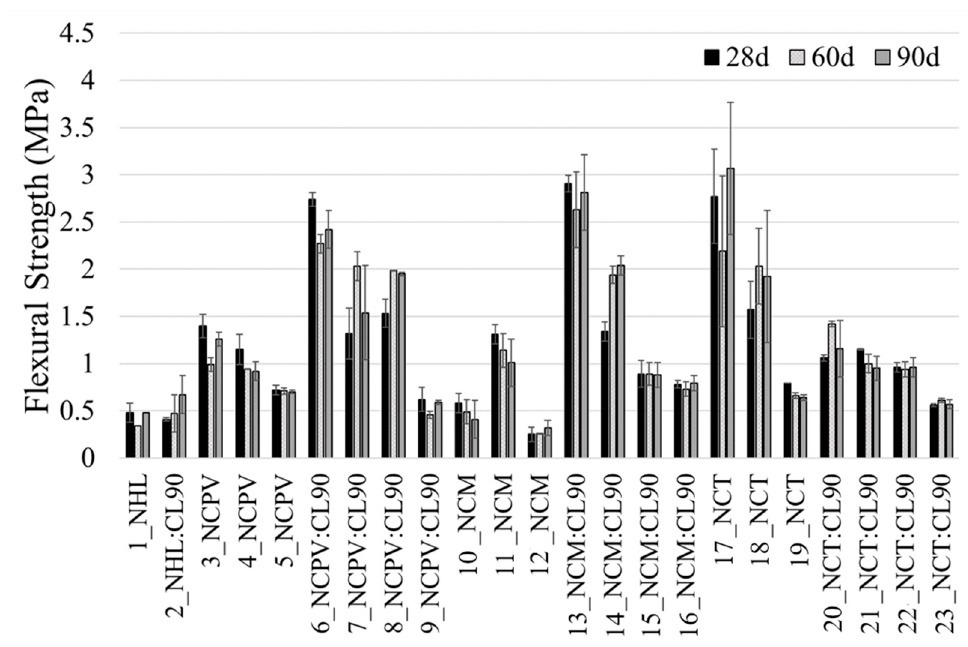
Figure 8. Flexural strength of the mortars. Flexural and compressive strengths of individual mortars show similar trend (Figures 8 and 9). Comparing the data at 90 days of curing, the lowest values of Rf and Rc shows 12_NCM (1:2 b/a) mortar (0.32 and 0.77 MPa, respectively), followed by 1_NHL and 2_ NHL: CL90 mortars (0.48 and 1.23 MPa, 0.67 and 1.60 MPa, respectively). Addition of CL90 to NHL mortar (2_NHL:90CL) improved flexural and compressive strengths values by 30 and 23%, respectively, when compared to